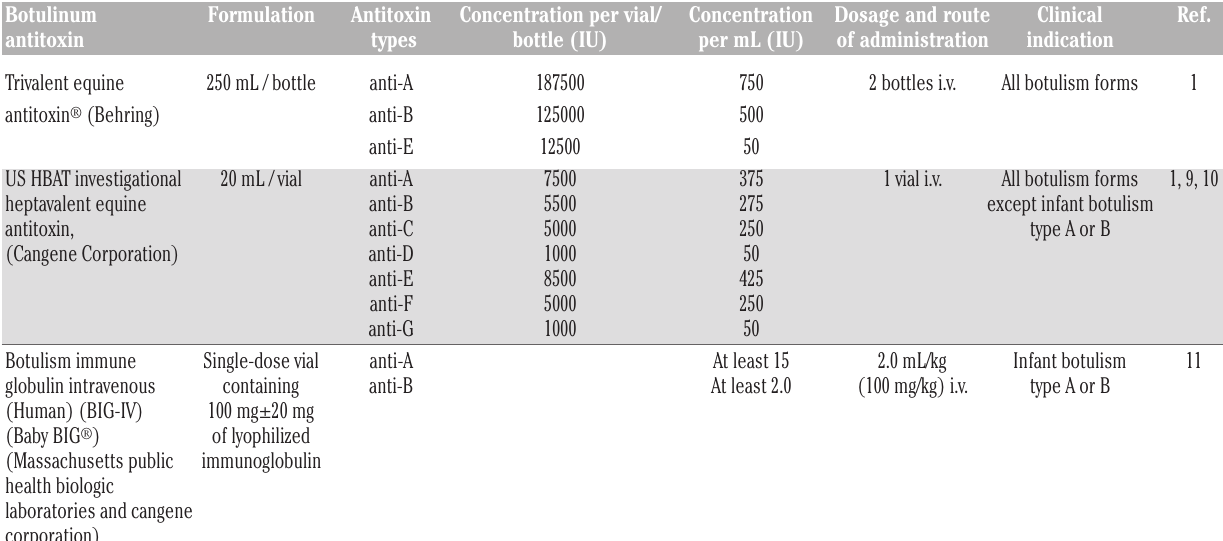
Table 1. Botulinum Antitoxin formulations available in Italy and in the US.